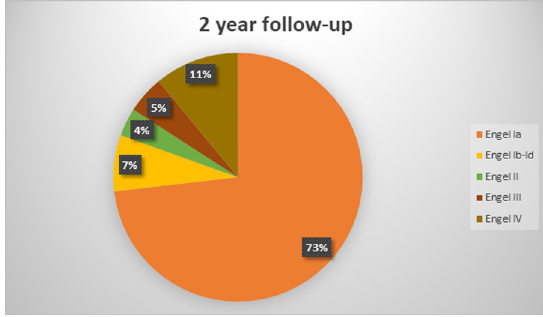
Fig 3. Long-term seizure outcomes. 2 year follow-up, 82 patients (Engel classification).